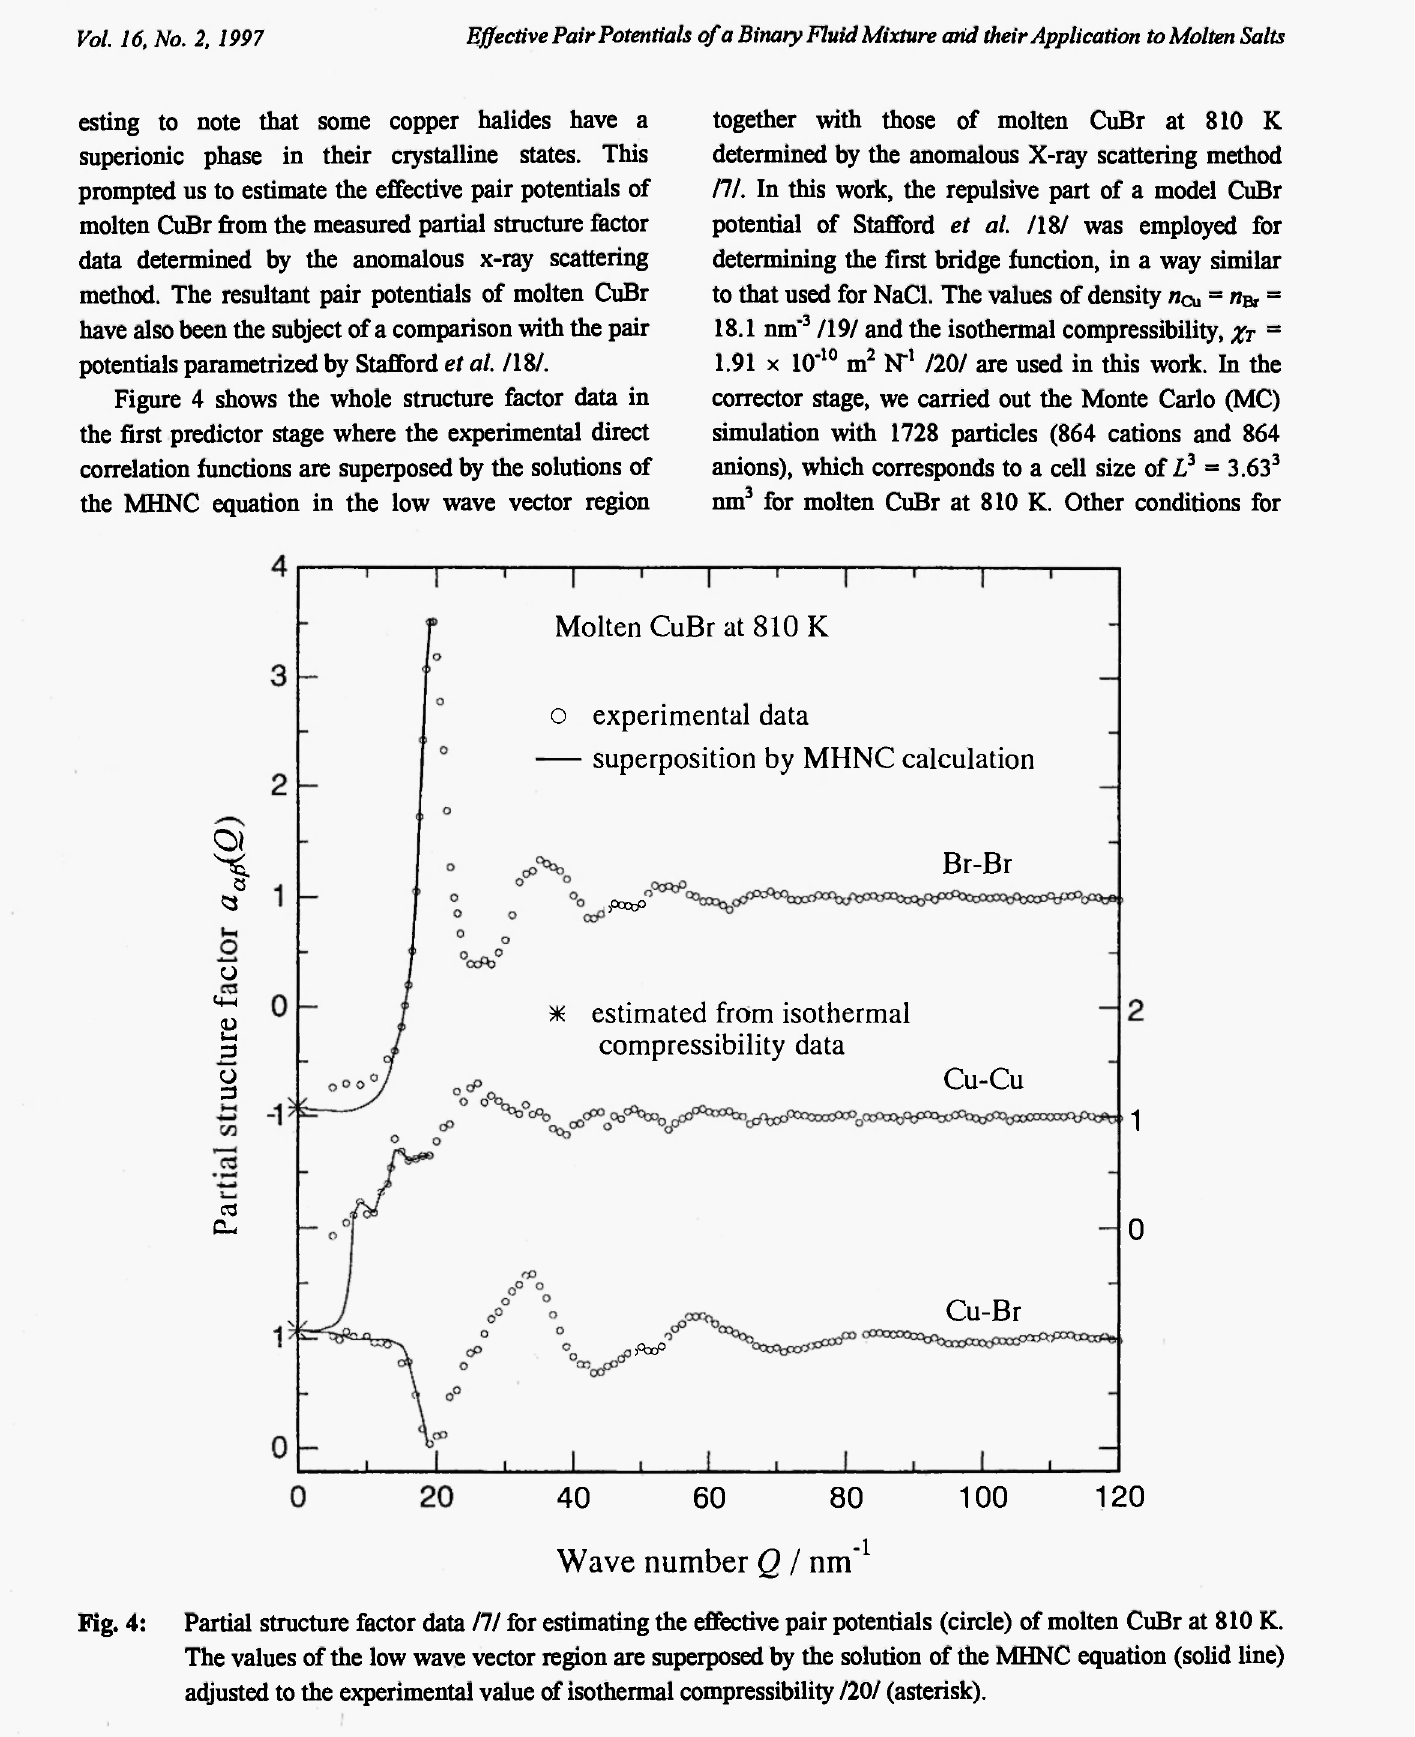
Fig. 4: Partial structure factor data 111 for estimating the effective pair potentials (circle) of molten CuBr at 810 K. The values of the low wave vector region are superposed by the solution of the MHNC equation (solid line) adjusted to the experimental value of isothermal compressibility 720/